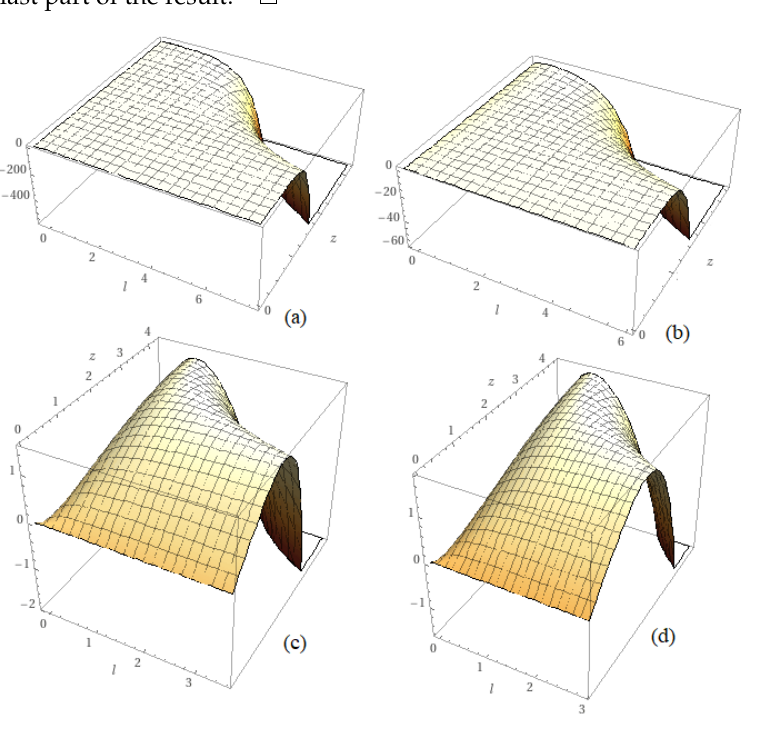
Figure 1. 3D–plot of the maximum function of convexity for (cid:36) , ( a ):0; ( b ):0.25; ( c ):0.5; ( d ):